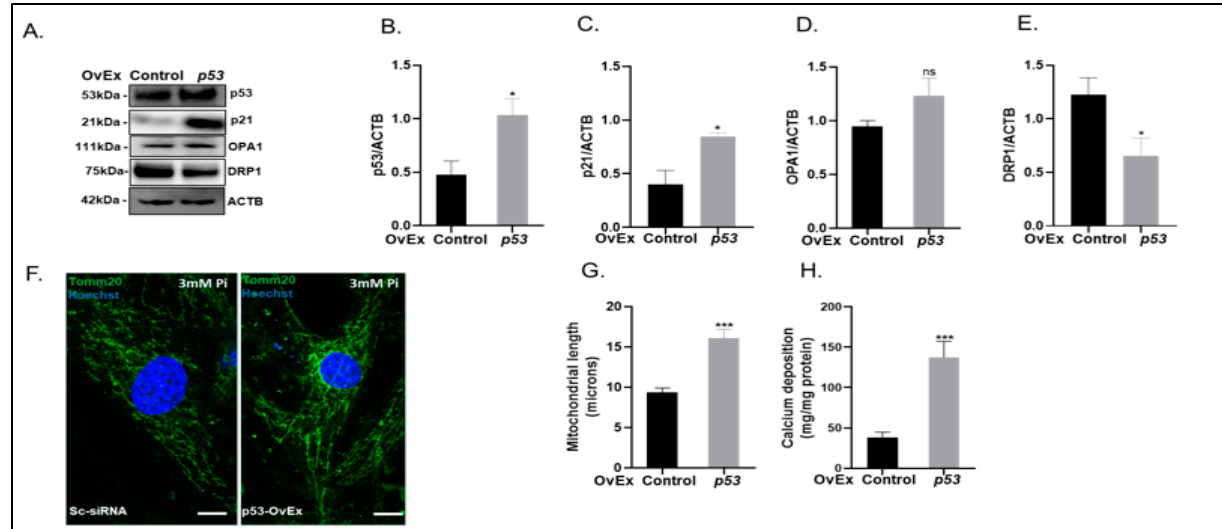
Figure 8. Overexpression of p53 enhances mitochondrial length, senescence and vascular calcification. VSMCs were transfected with either control or p53 vector (p53-OvEx) and cultured with high phosphate (3mM Pi) for up to 7 days. ( A ) Representative immunoblotting of whole cell lysates and associated quantification of ( B ) p53 and ( C ) p21 ( D ) Optic Atrophy Protein 1 (OPA1) expression compared with ACTB ( β -actin) and ( E ) Dynamin-related protein 1 (DRP1). ( F ) Representative images of TOM20 staining ( G ) associated quantification of mitochondrial length. ( H ) Calcium content (mg/mg protein) of VSMCs. Data shown as mean +/ − S.E.M. (n = 3–6) * p < 0.05; *** p < 0.001 compared to control.